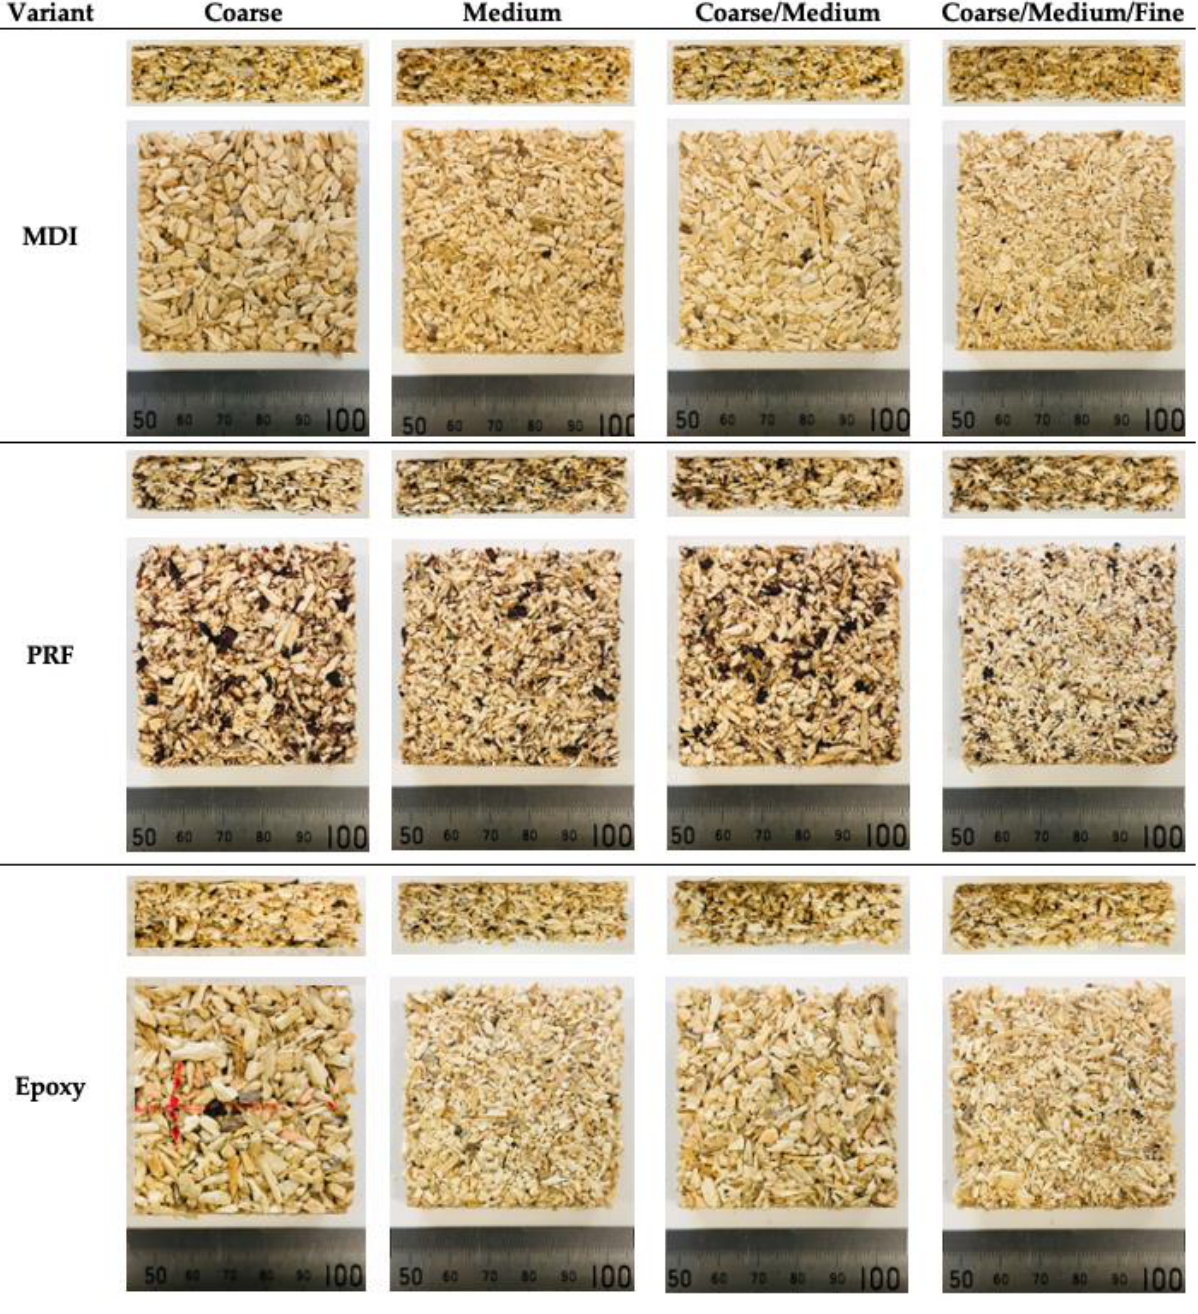
Figure 3. Overview of panel compositions by means of IB specimen. (Only high particle loading and high adhesive content specimen depicted).